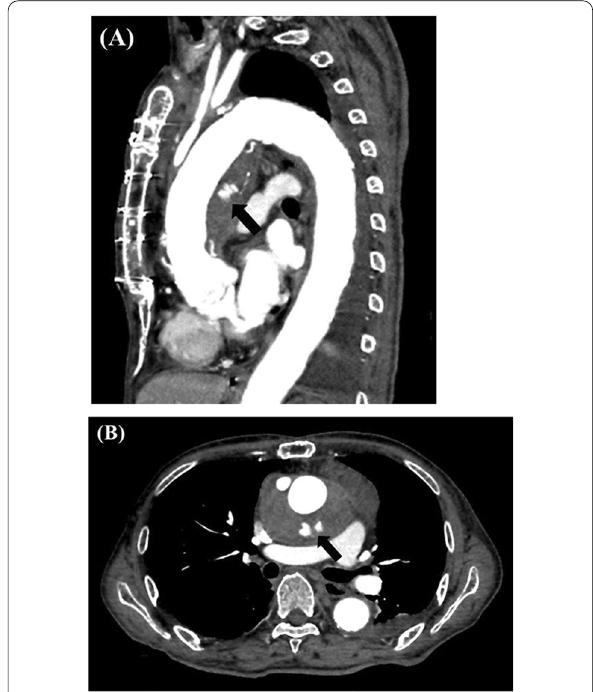
Fig. 1 Contrast-enhanced CT findings. An intra-mediastinal hematoma around the vascular graft of the ascending aorta and extravasation on the dorsal side of the center of the vascular graft (black arrows). A Sagittal view; B Axial